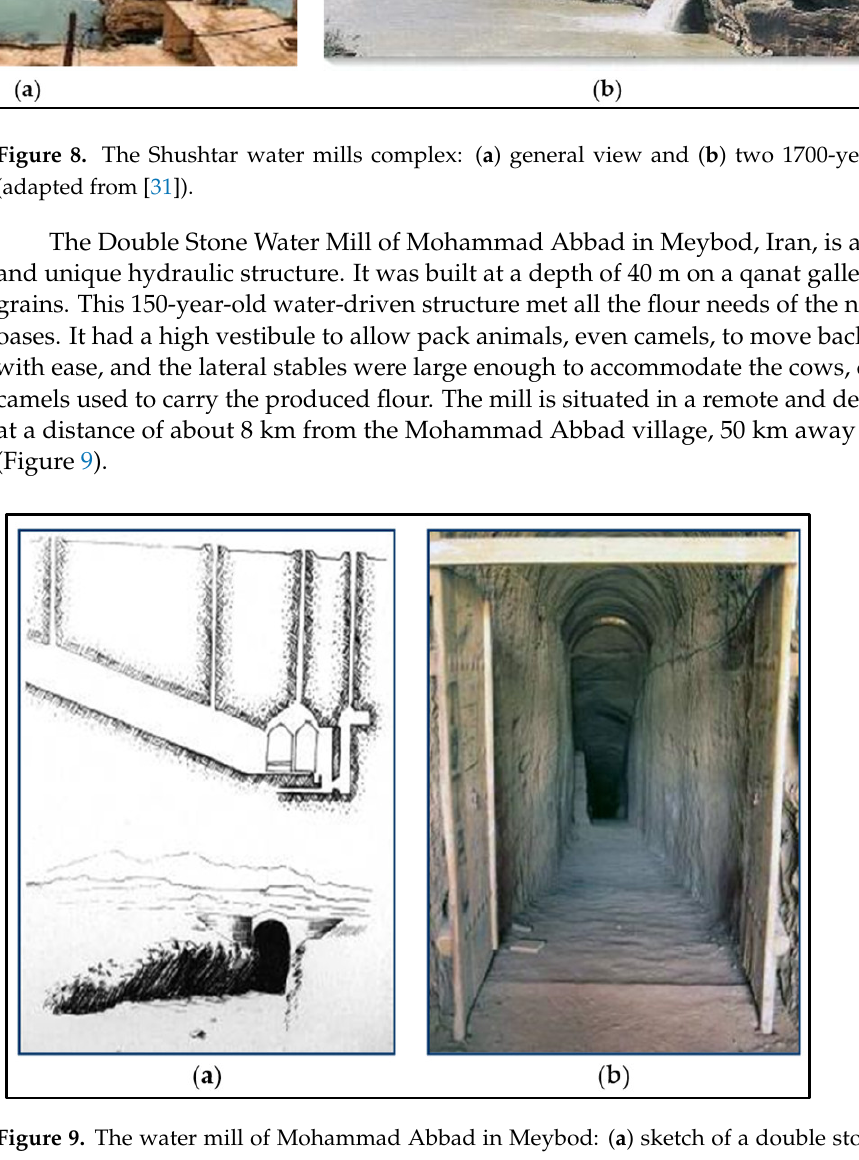
Figure 8. The Shushtar water mills complex: ( a ) general view and ( b ) two 1700-year-old mills (adapted from [31]).